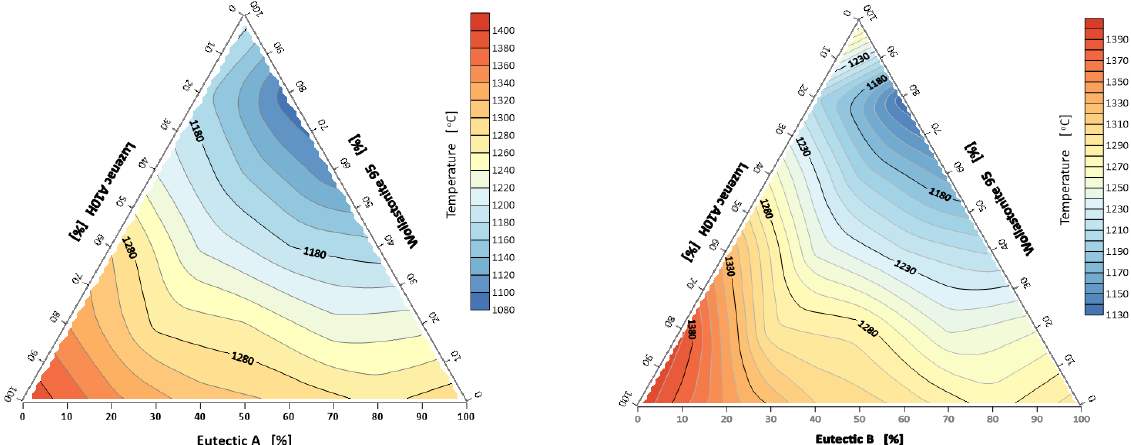
Figure 2. Corner rounding temperatures: A/B-eutectic–Luzenac A10H–Wollastonite 95.